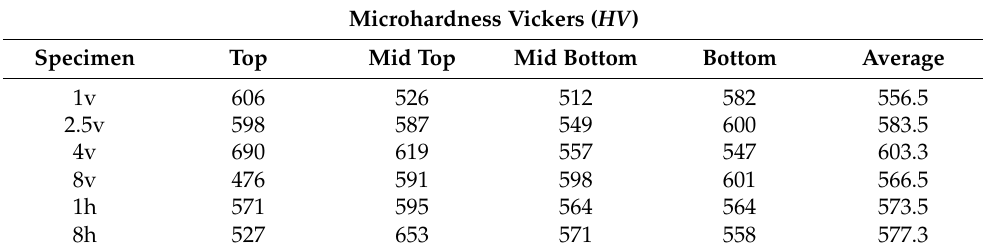
Table 3. Microhardness Vickers